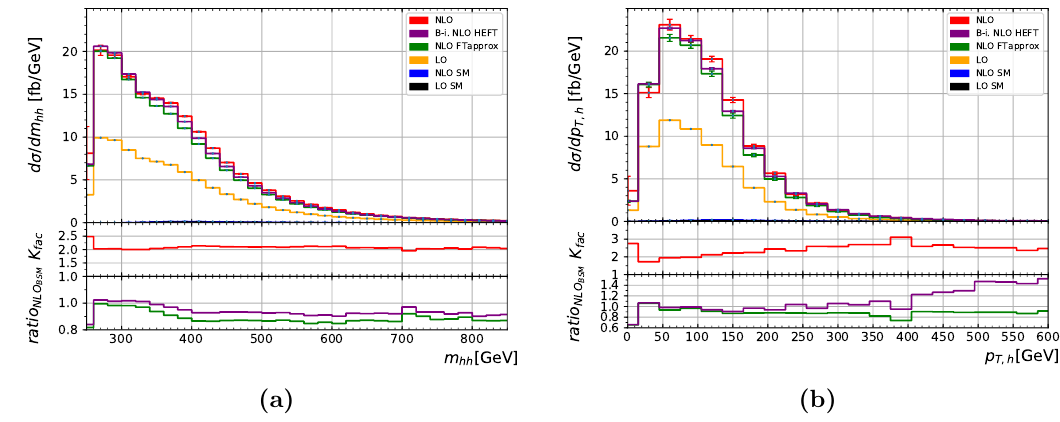
Figure 24. Same as (cid:12)gure 12 but for benchmark point 12, c hhh = 15 ; c t = 1 ; c tt = 1 ; c ggh = c gghh = 0.